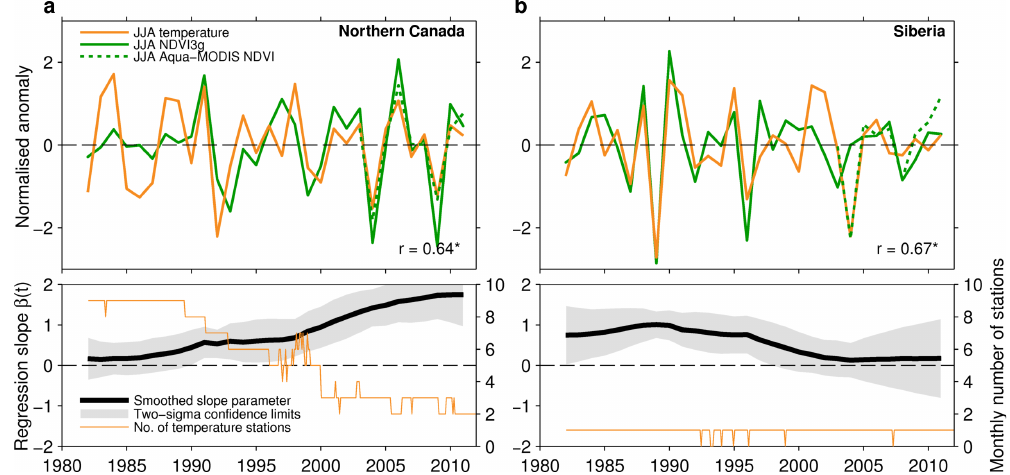
Figure 8. Illustration of the time-dependent association between interannual variability in summer NDVI and summer temperature in the regions indicated by the rectangles in Figure 7a. ( a ) Comparison of spatially averaged time series for the region in northern Canada (top) and the corresponding Kalman filter regression coefficients and pointwise confidence intervals over the period 1982–2011 (bottom). Where any of the confidence limits includes zero, the regression weights are not considered statistically significant at that point in time. The monthly number of station temperature records in the region included in the CRU TS 3.20 dataset is also shown (bottom). The Aqua-MODIS NDVI average for the same region is shown as a dotted line for comparison. The overall correlation between NDVI3g and temperature is displayed along with its significance (*: p < 0.05); ( b ) Same as (a) but for a region in